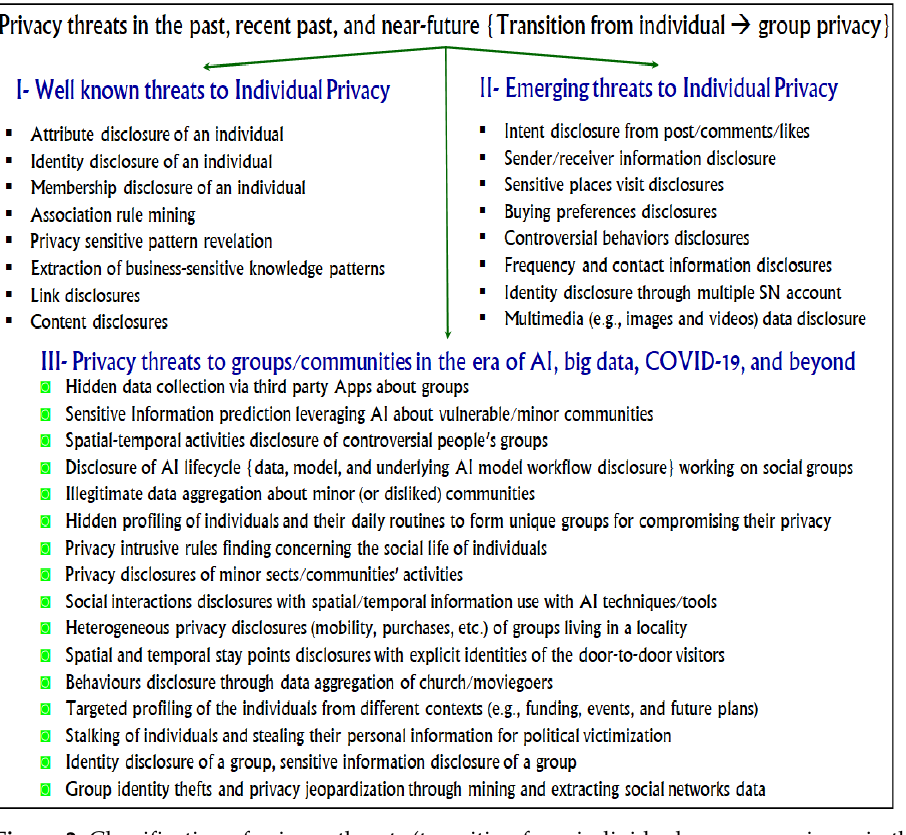
Figure 2. Classification of privacy threats (transition from individual → group privacy in the near-